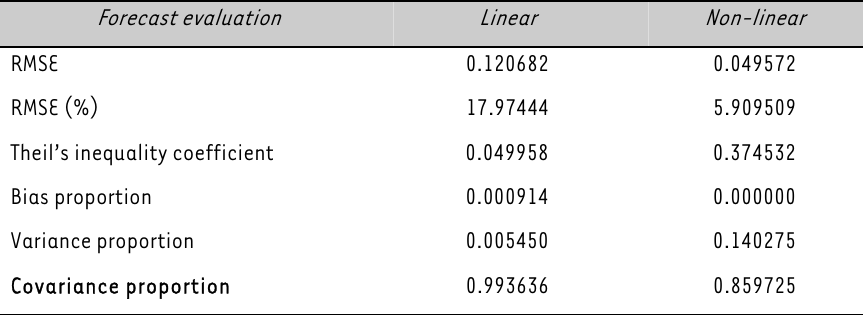
TABLE 10: Comparison of forecast evaluation